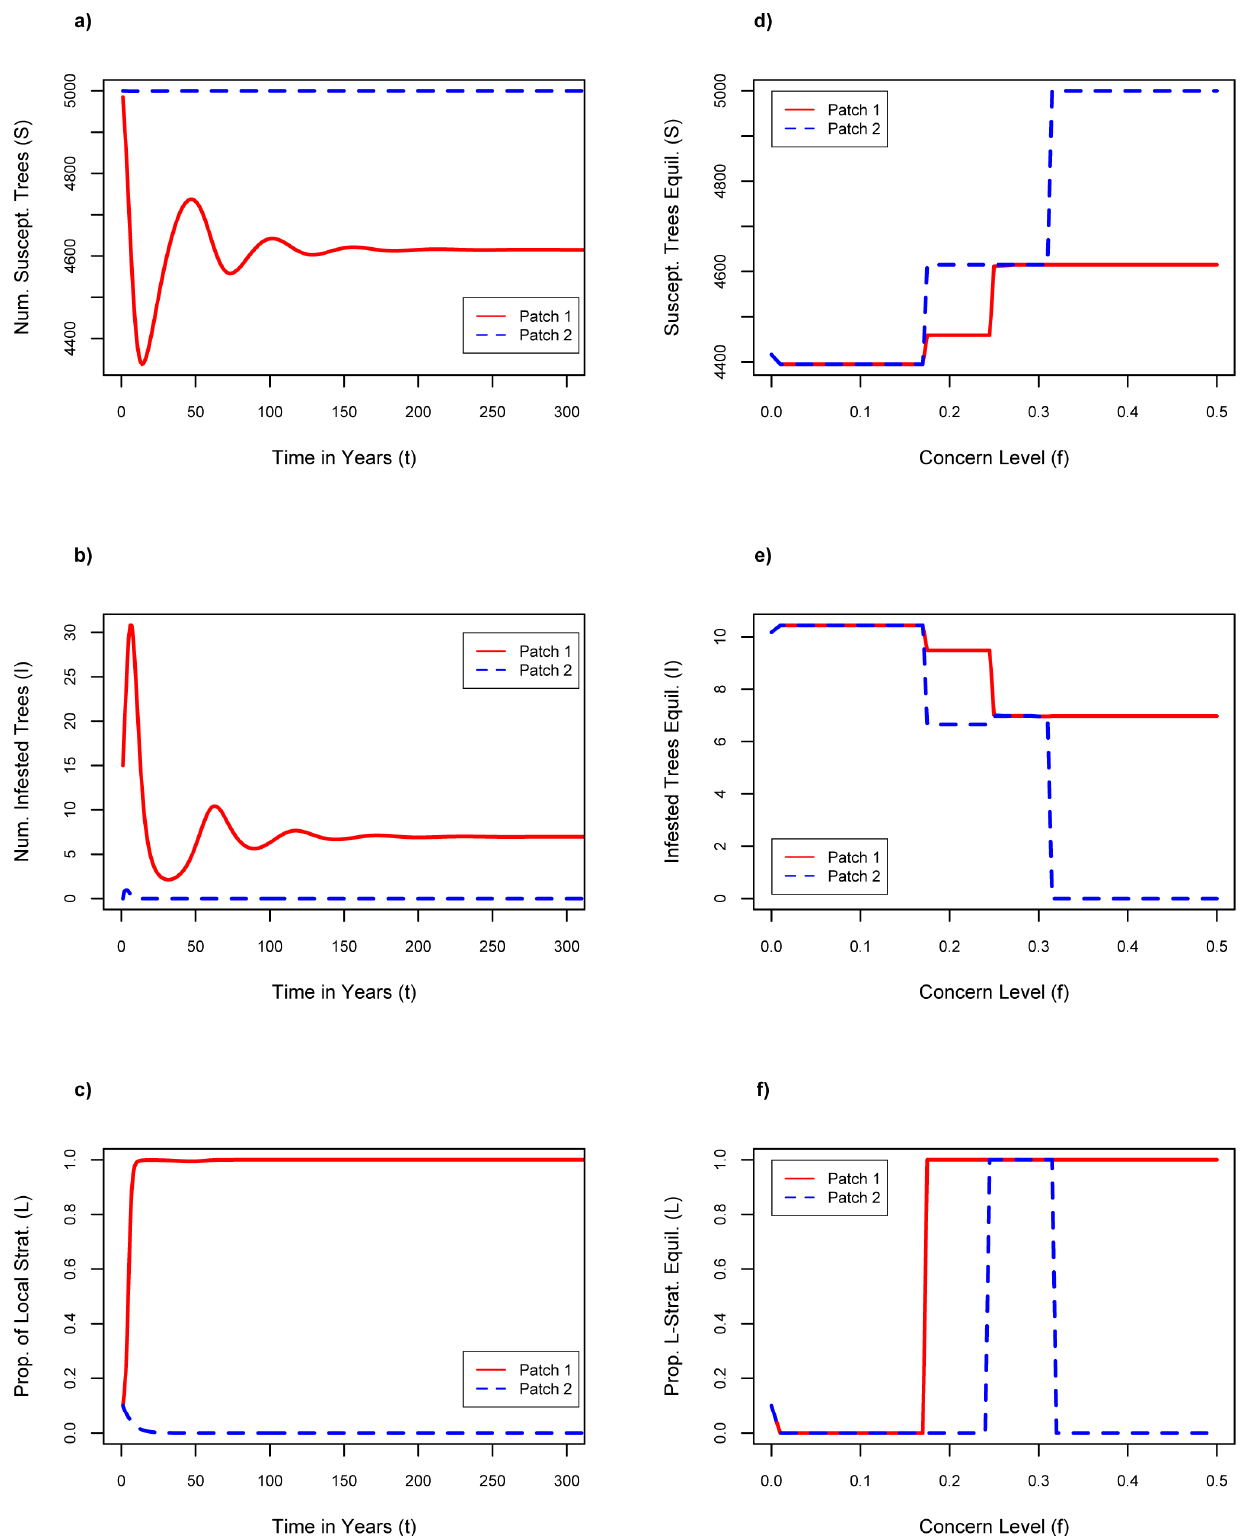
Figure 4. Results of increasing concern of infestation. Increase concern of infestation: n=0.1, s =0.1, Cl= $ 6.75 where a) number of susceptible trees as a function of time with f=0.35; b) number of infested trees as a function of time with f=0.35; c) proportion of local firewood strategists as a function of time with f=0.35; d) susceptible tree equilibria for increasing values of f; e) infested tree equilibria for increasing values of f; f) proportion of local firewood strategist equilibria for increasing values of f.